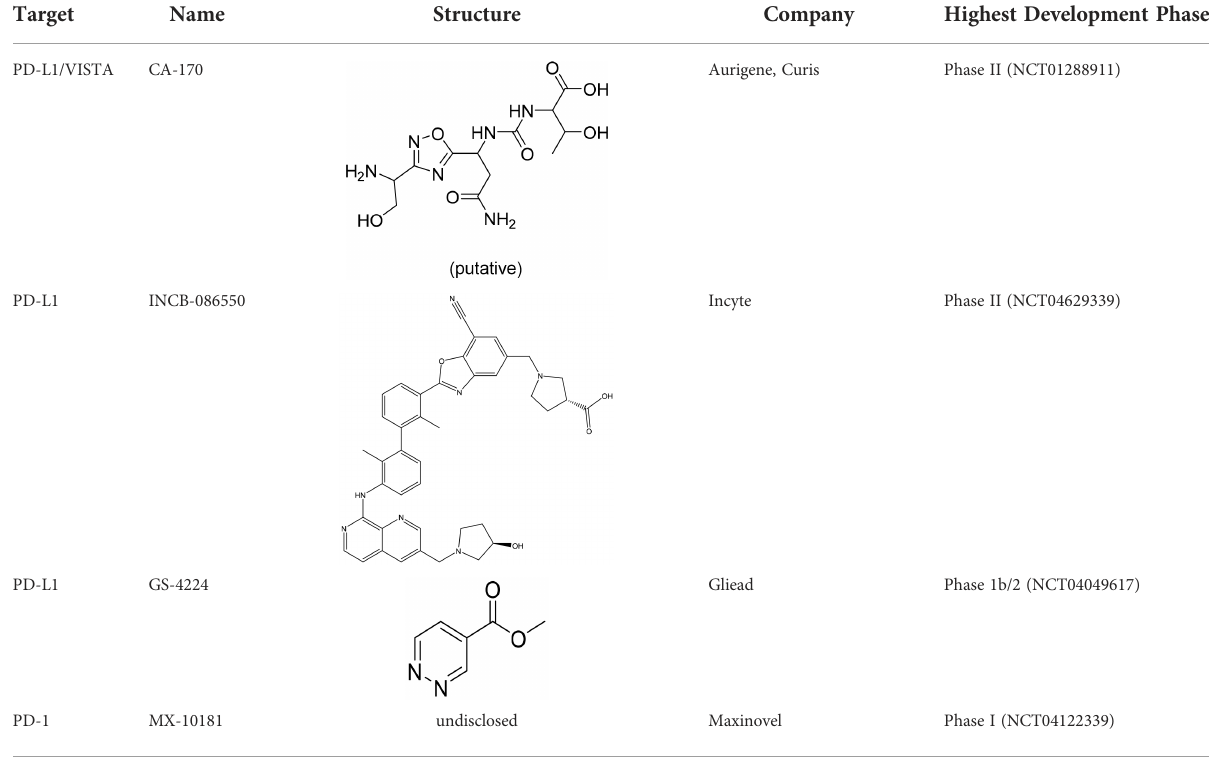
TABLE 2 Summary of major marketed and clinically reported small molecule immunotherapy drugs (Up to March 2022).